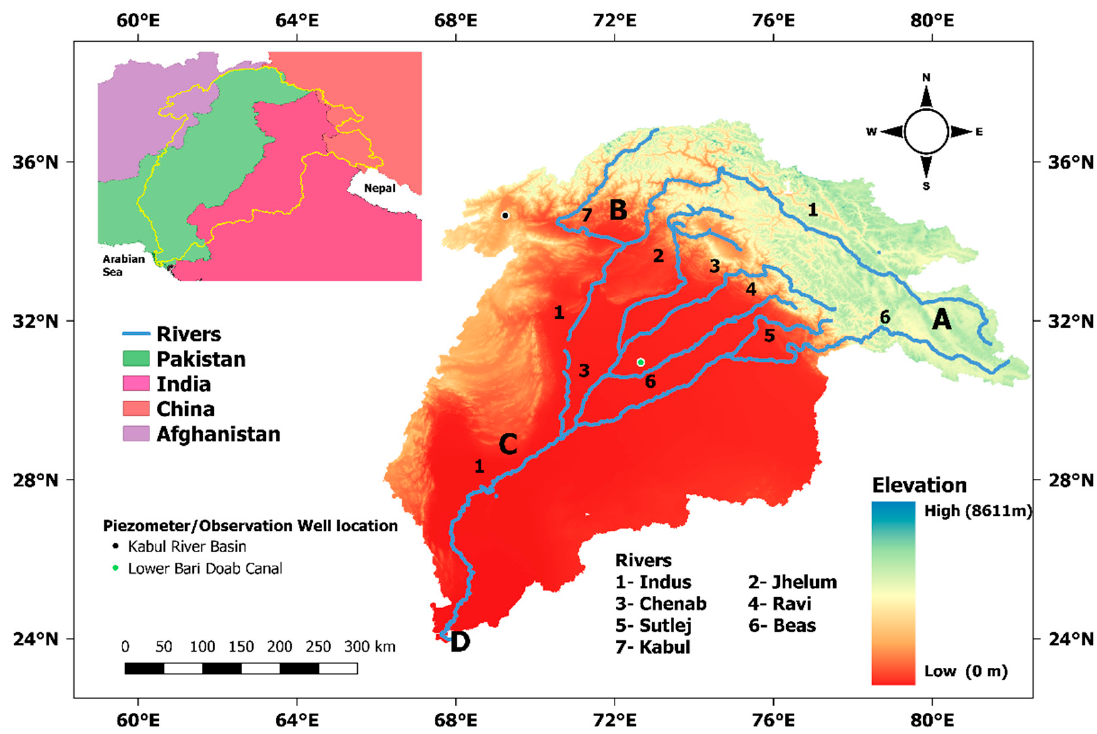
Figure 1. Transboundary Indus Basin with its tributaries and digital elevation model.